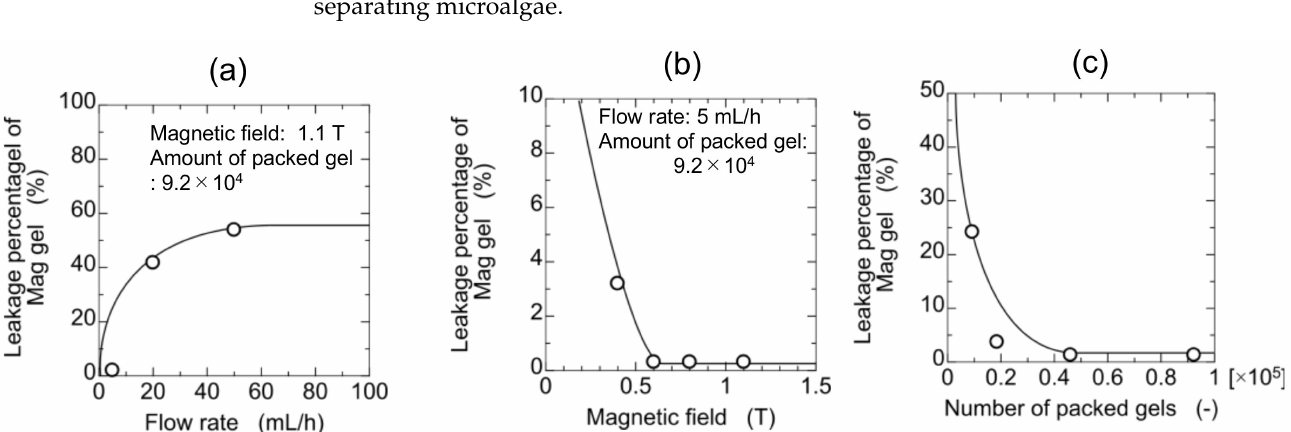
Figure 3. Elution of Mag gel from a gel-packed column in a permeation of water. ( a ) Effect of flow rate, ( b ) effect of the magnetic field, and ( c ) effect of a number of packed gels.